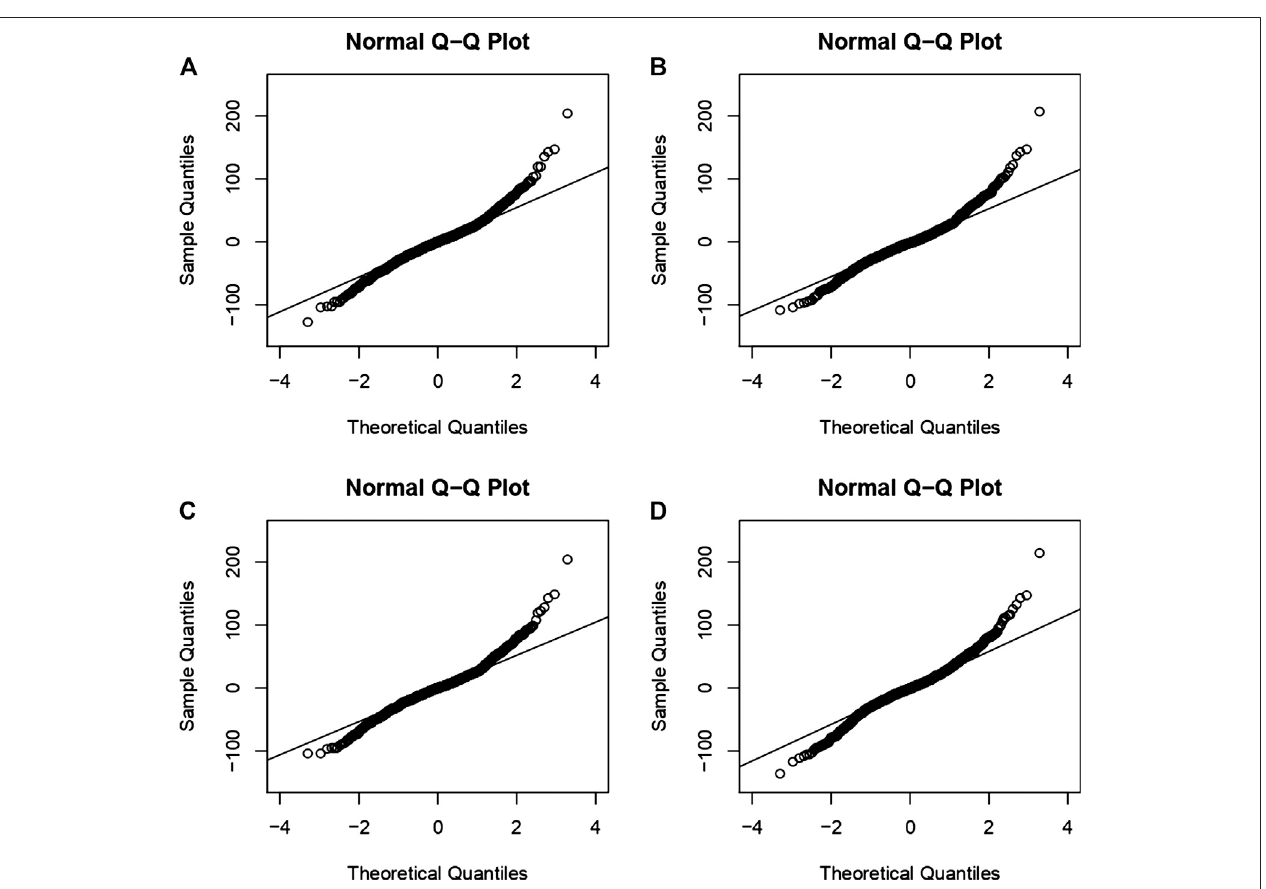
FIGURE 6 | Q-Q norm of the residuals time series for the estimated Models (A – D) as labeled in Table 1 to check the normality assumption.